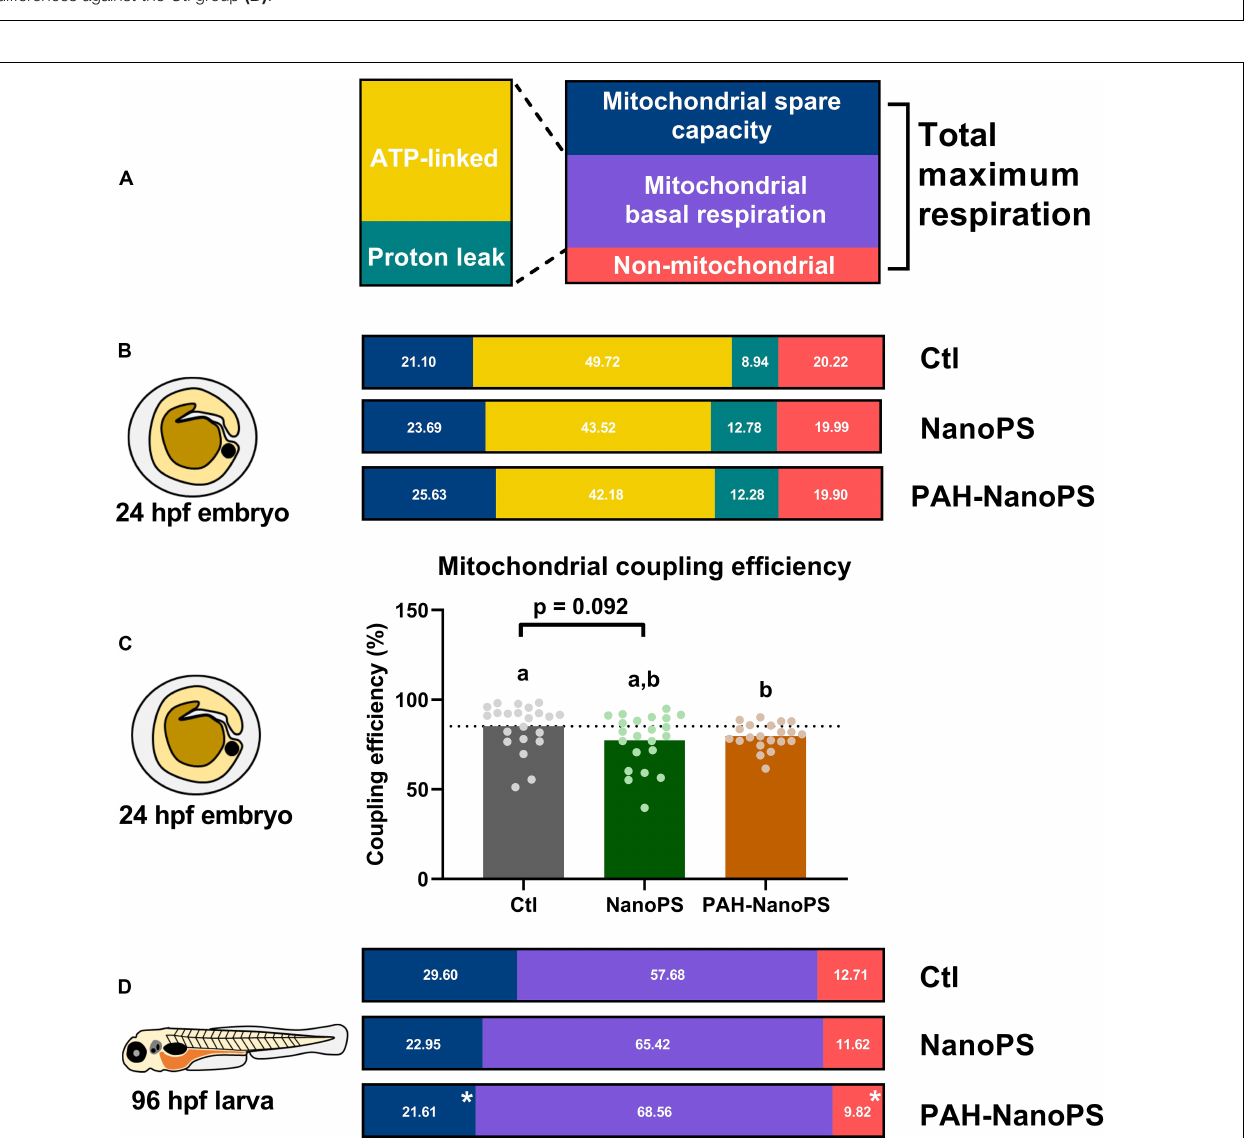
Frontiers in Environmental Science |